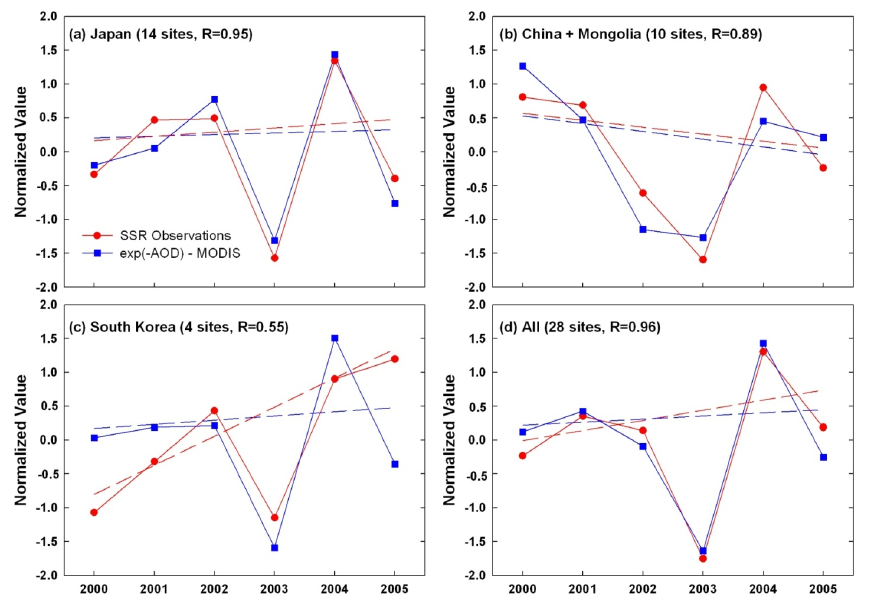
Fig. 14. Evolutions of normalized annual mean SSR observations and exp(-AOD) from MODIS at SSR observation sites in (a) Japan, (b) China and Mongolia, (c) South Korea, and (d) East Asia (all 28 sites). Dashed lines represent the linear tendencies excluding the year 2003 data.